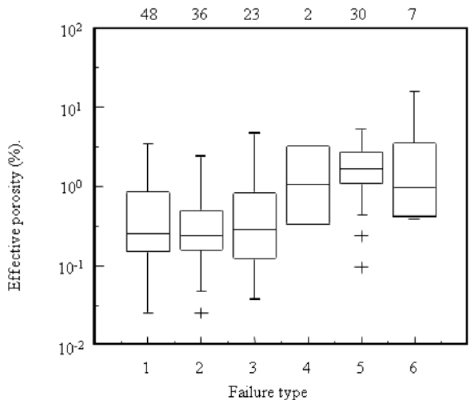
Figure 26. Well-core porosity, UK Nirex Borrowdale volcanics, Sellafield nuclear facility [27].